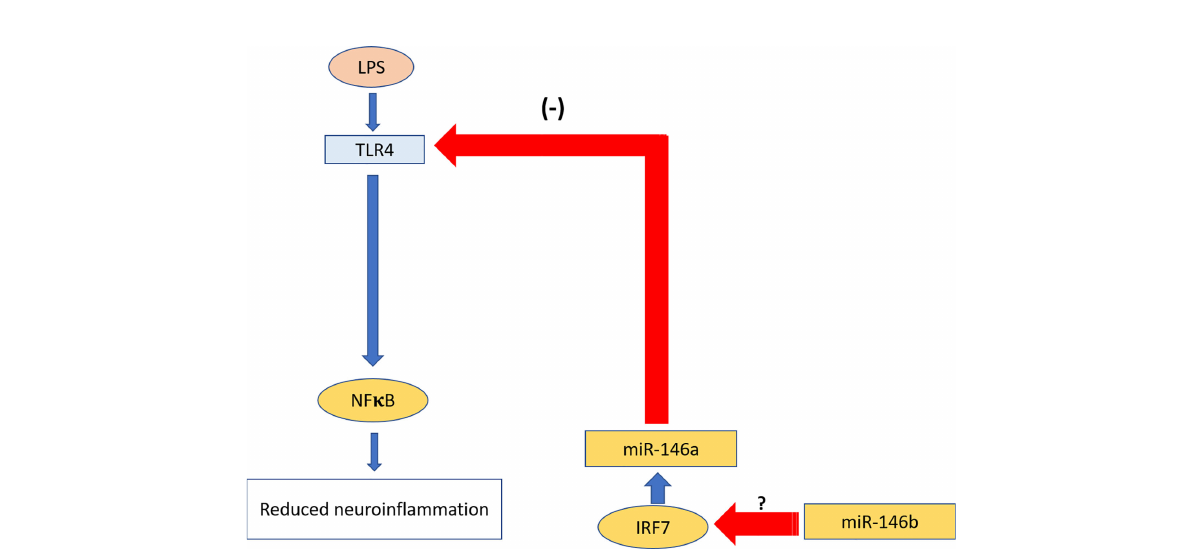
FIGURE 11 Summary of the crosstalk between miR-146a and miR.146b in the regulation of neuroin fl ammation. miR-146b leads to over-expression of miR- 146a transcriptional regulator Irf7 , which in turn induces upregulation of miR-146a. miR-146a inhibits activation of TLR4 upon LPS challenge and consequent inhibition of neuroin fl ammation. Red arrows show inhibition; blue arrows show